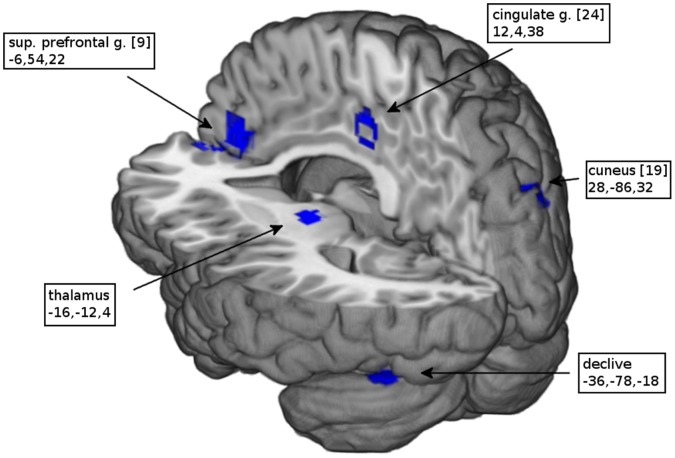
Activation map of controls.Significant activations of trauma-exposed controls in response to trauma-related stimuli as compared to a neutral condition. (Numbers in brackets indicate Brodmann areas and coordinates of the peak voxel are in Talairach space).